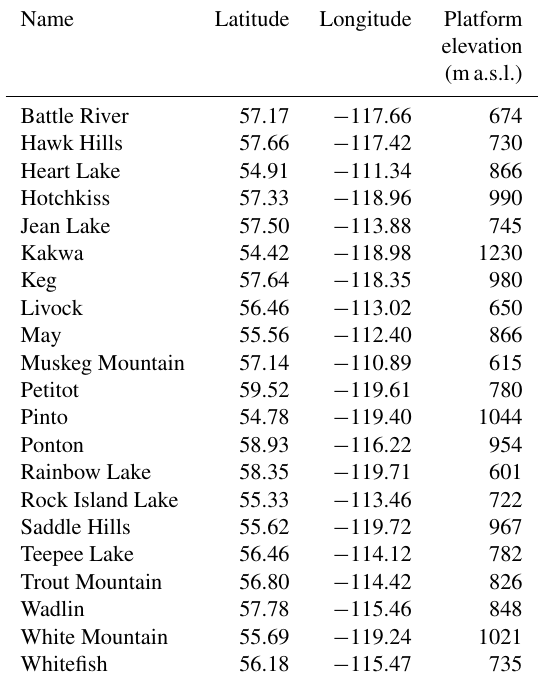
Table 1. Lookout towers used in Alberta smoke plume observation study.